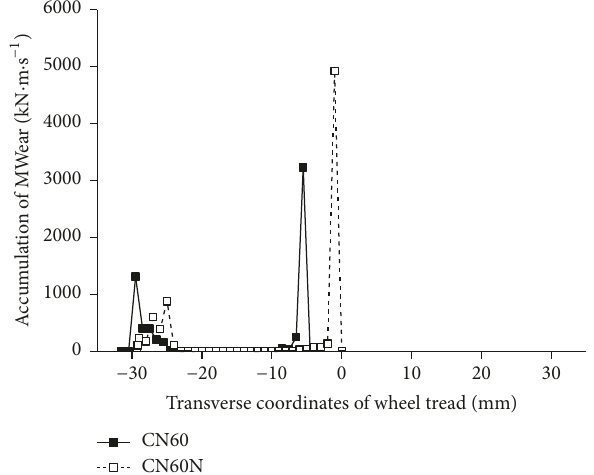
Figure 15: Cumulative wear power dissipation (LMAworn wheel tread matched with the different rail